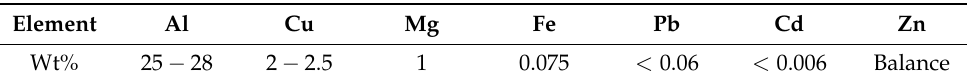
Table 1. Chemical composition of ZA27 alloy used to manufacture metal foams